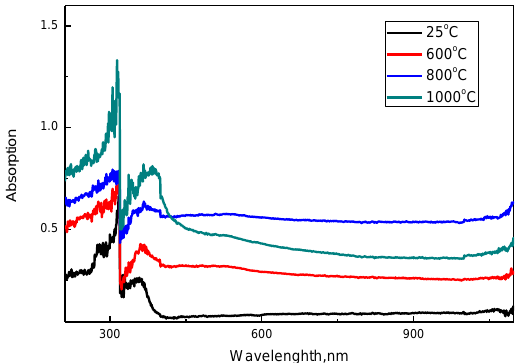
Figure 4. Results of UV spectroscopy of the studied nanostructured ceramics Y 2 O 3 /TiO 2 -Y 2 TiO 5 doped CNTs.